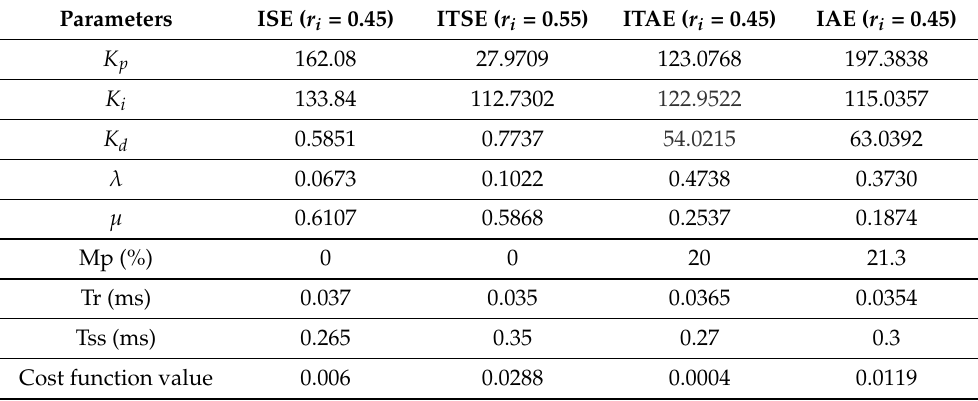
Table 3. Response of CI optimized converter with different cost